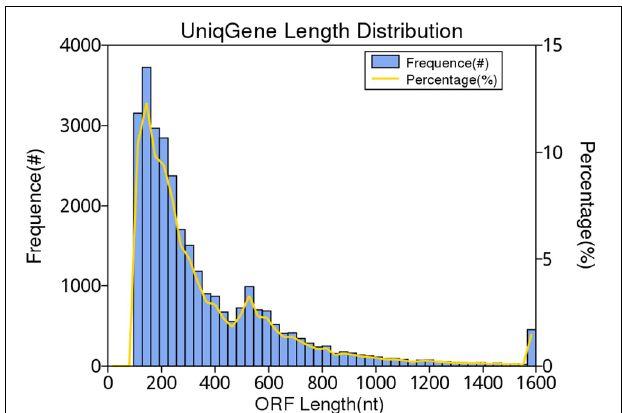
FIGURE 3 | Distribution of scaftig lengths across samples. The first vertical axis (frequency, #) indicates the number of scaftigs, the second vertical axis (percentage, %) indicates the percentage of the number of scaftigs, and the horizontal axis indicates the scaftig length.